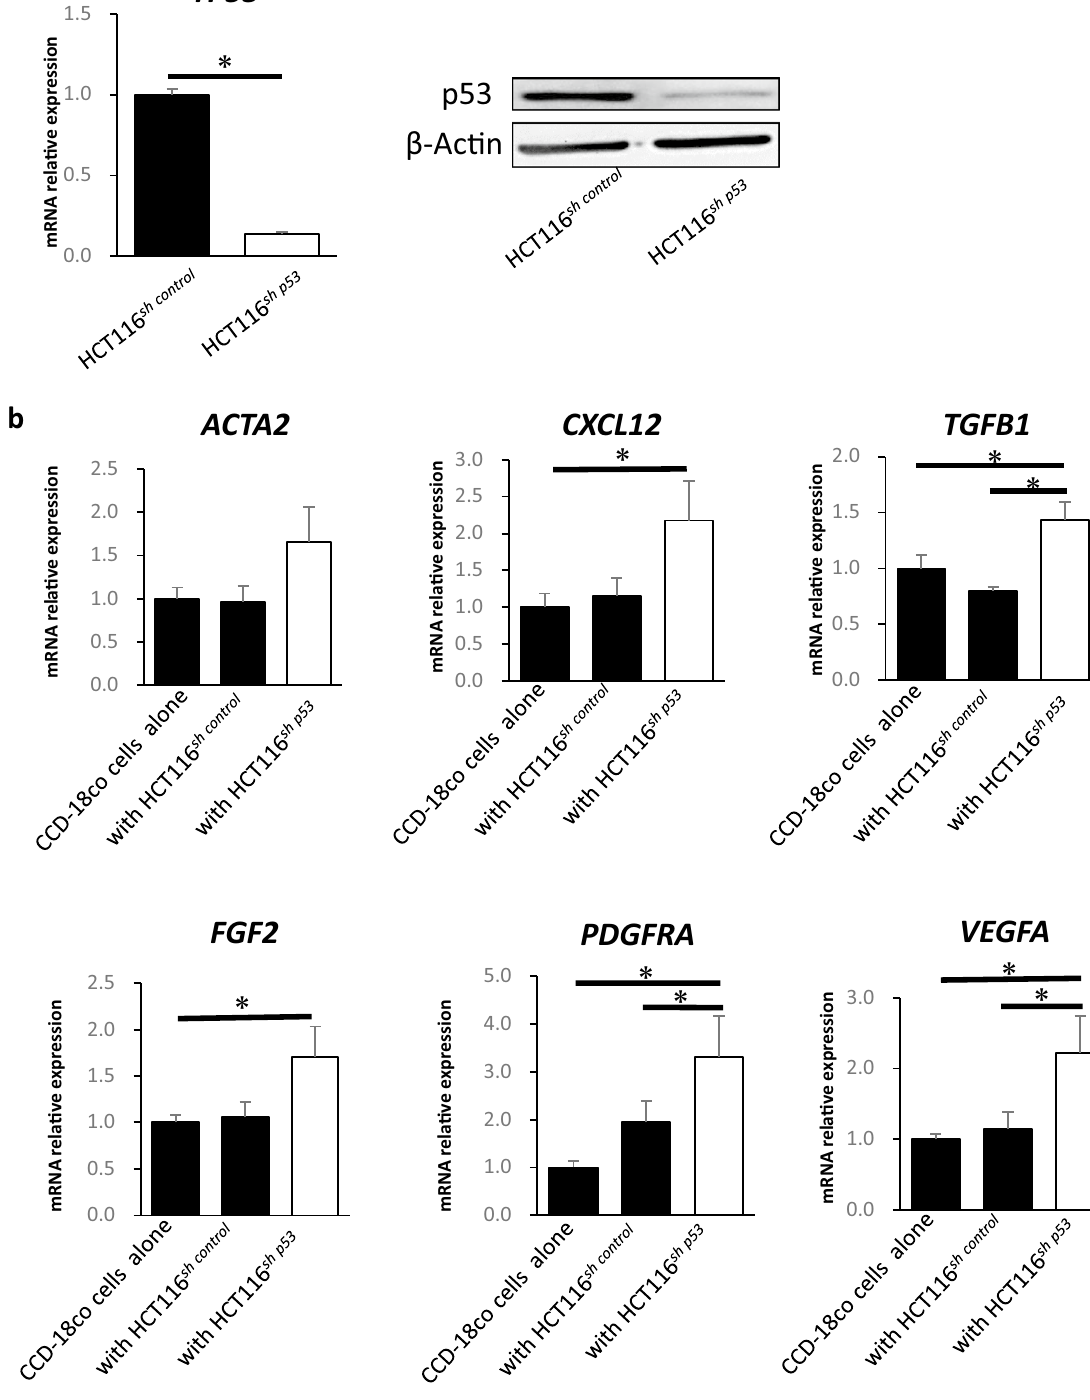
Figure 1. Inactivation of p53 in cancer cells activates fibroblasts and suppresses autophagy. ( a ) TP53 mRNA expression analysis in HCT116 sh p53 and HCT116 sh control cells using quantitative real-time PCR (qRT-PCR) (left; mean ± SD, *P < 0.05). The expression of p53 in HCT116 sh p53 and HCT116 sh control cells using western blotting (right). ( b ) Relative expressions of FGF2, PDGFRA, ACTA2, CXCL12, TGFβ1 , and VEGFA mRNAs in CCD- 18Co cells co-cultured with or without HCT116 sh p53 or HCT116 sh control cells analysed using qRT-PCR ( n = 3, mean ± SD, *P < 0.05). ( c ) Cell numbers of CCD-18Co cells co-cultured with HCT116 sh p53 or HCT116 sh control cells for 24, 48, and 72 h. ( n = 3, mean ± SD, *P < 0.05). ( d ) Western blotting and autophagic flux assays of CCD- 18Co cells co-cultured with or without HCT116 sh p53 or HCT116 sh control cells ( n = 4, mean ± SD, *P < 0.05). ( e ) Western blotting and autophagic flux assays of CCD-18Co cells co-cultured with or without HT29 cells ( n = 5, mean ± SD, *P < 0.05). Protein expression levels were measured using imageJ software 1.8.0_172 (https:// imagej. nih.